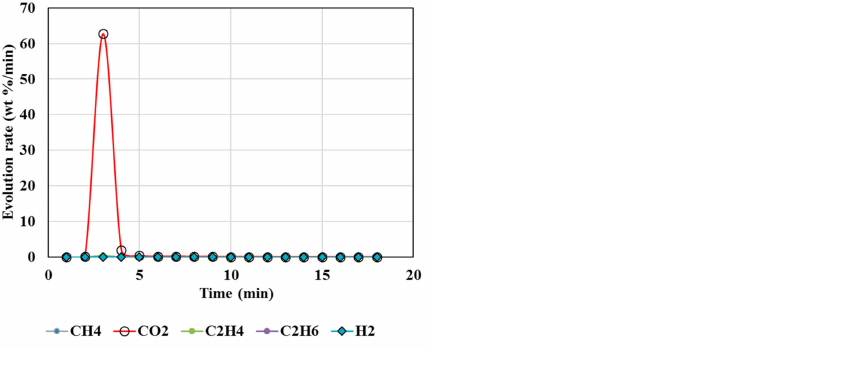
Figure 3. Gas Chromatography results of isothermal calcination of magnesite (Test 4, MgCO 3 · xH 2 O) at 1000 ◦ C.